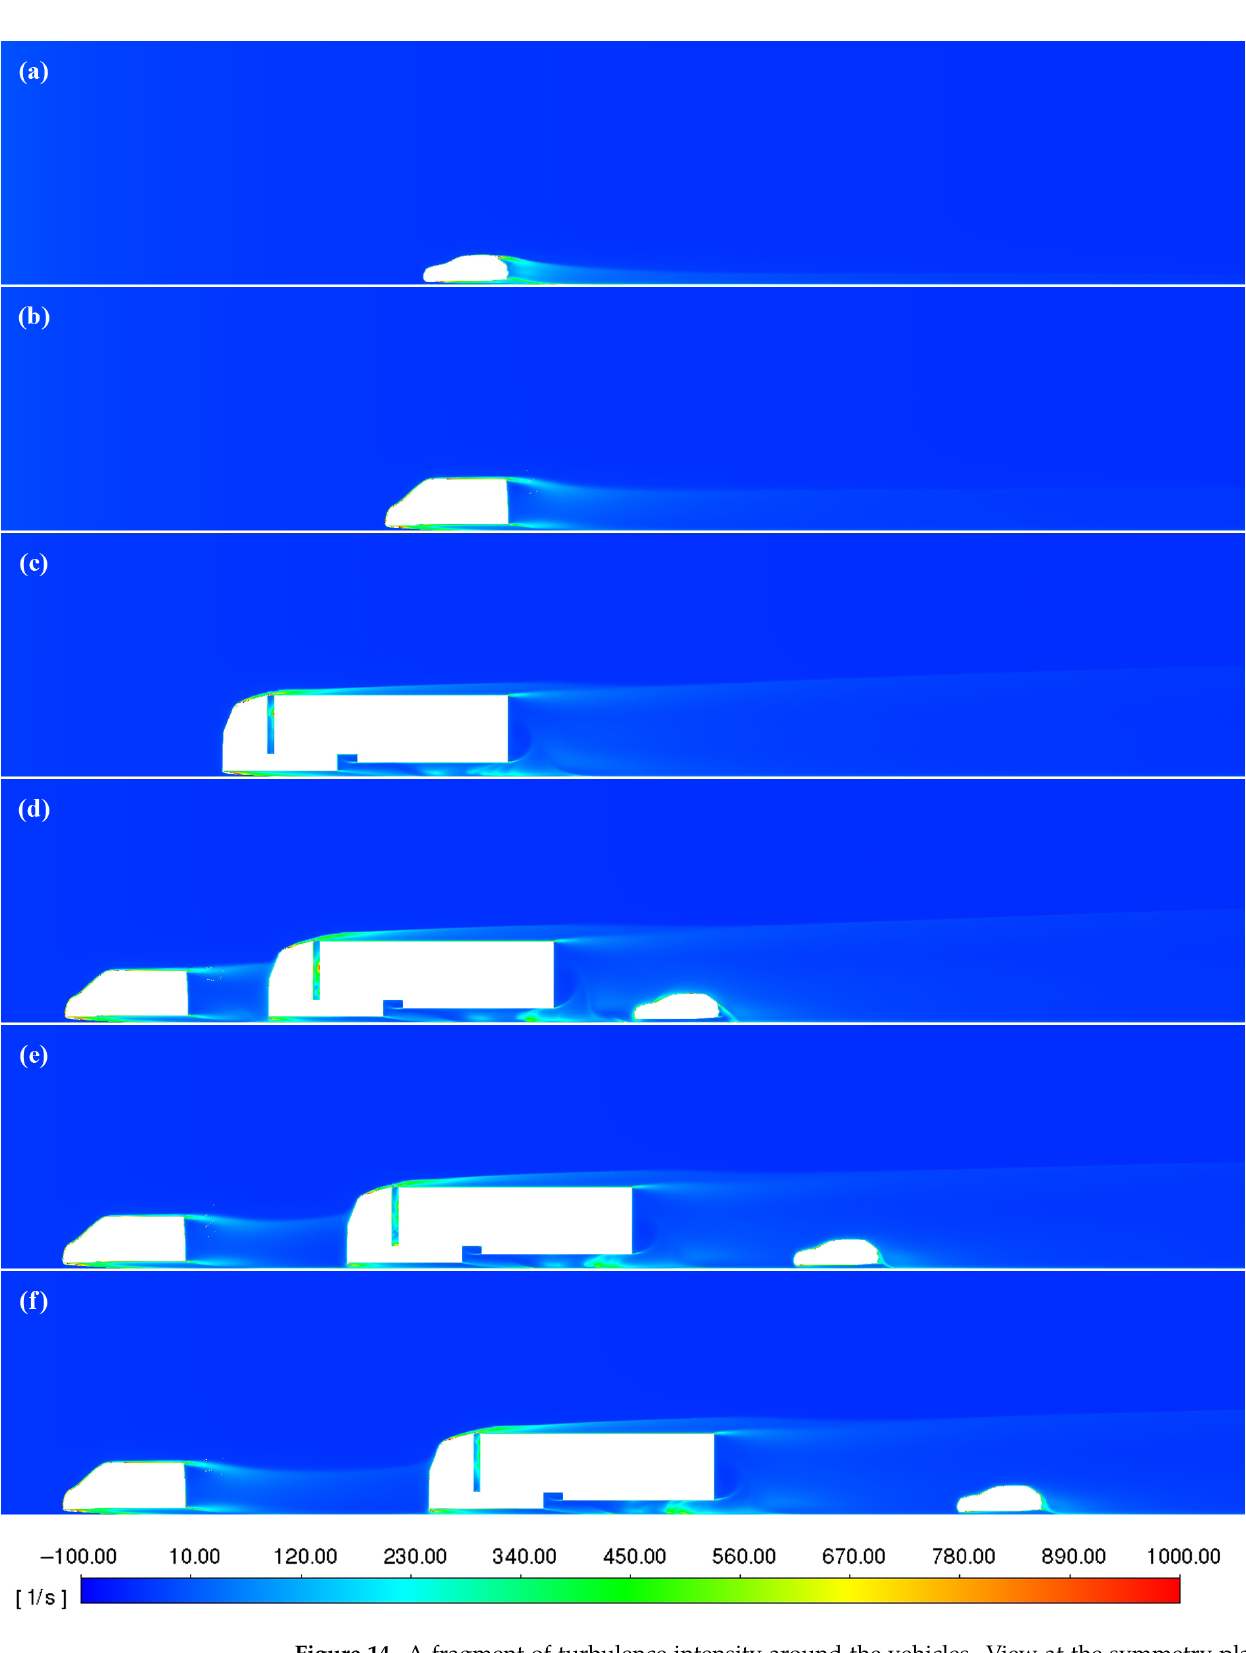
Figure 14. A fragment of turbulence intensity around the vehicles. View at the symmetry plane. ( a ) Single car, ( b ) single van, ( c ) single truck, ( d ) column of vehicles with a spacing of 4 m, ( e ) column of vehicles with a spacing of 8 m, ( f ) column of vehicles with spacing of 12